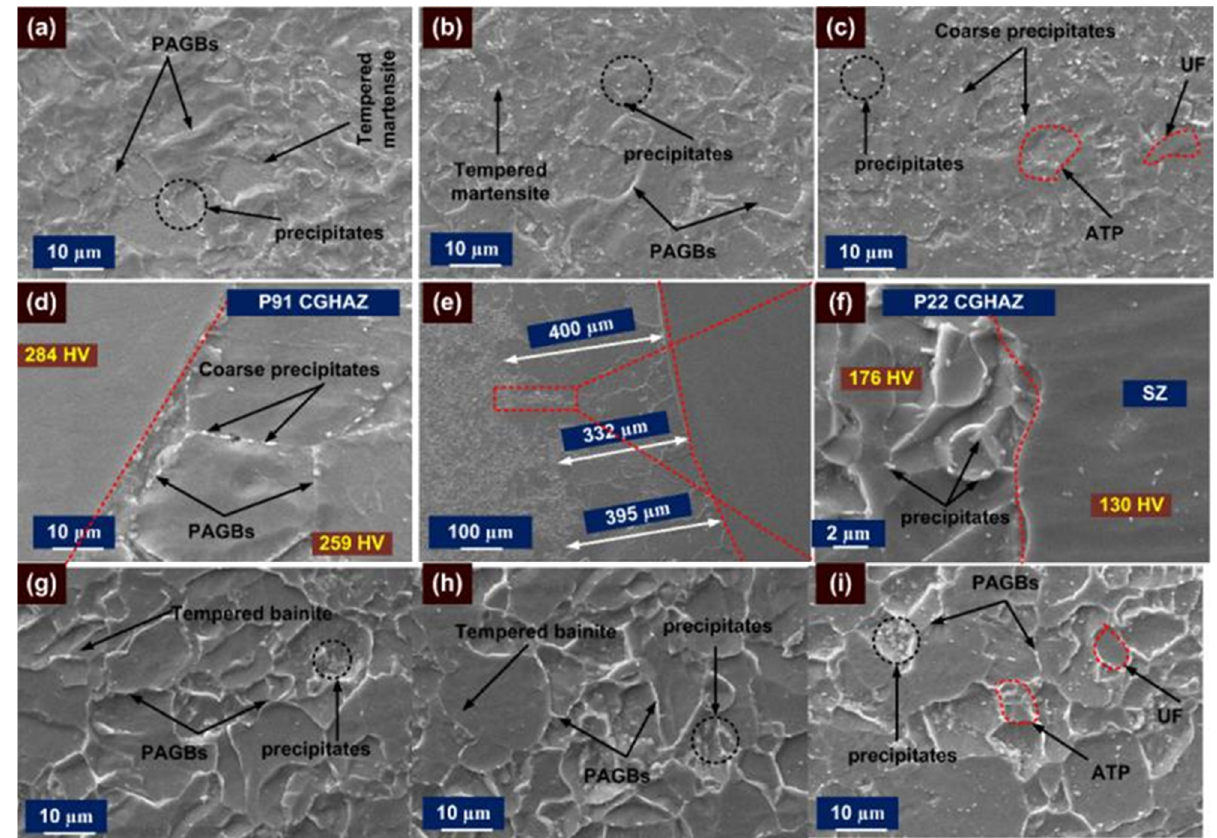
Figure 9. Typical SE image of HAZ region of P91 steel after PWHT: ( a ) coarse-grained HAZ, ( b ) fine-grained HAZ, ( c ) inter-critical HAZ; interface region: ( d ) on P91 side, ( e, f ) on P22 side; HAZ region of P22 steel: ( g ) coarse-grained HAZ, ( h ) fine-grained HAZ, ( i ) inter-critical HAZ.